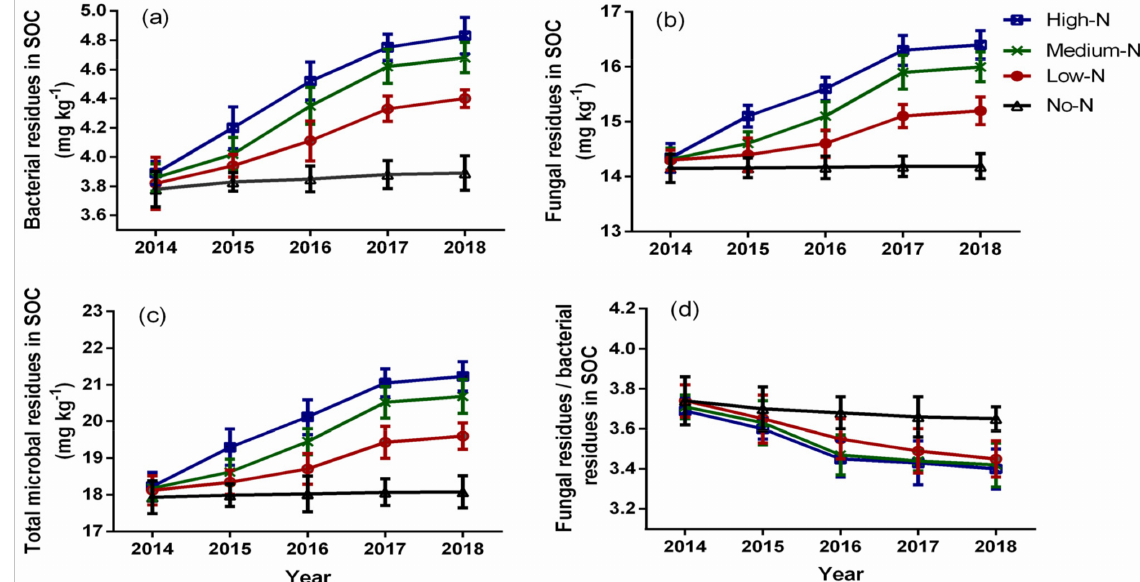
Figure 2. Effects of nitrogen enrichment on bacterial residues in SOC ( a ), fungal residues in SOC ( b ), total microbial residues in SOC ( c ), and ratio of fungal residues to bacterial residues in SOC ( d ). Bars represent ± standard error of means with four